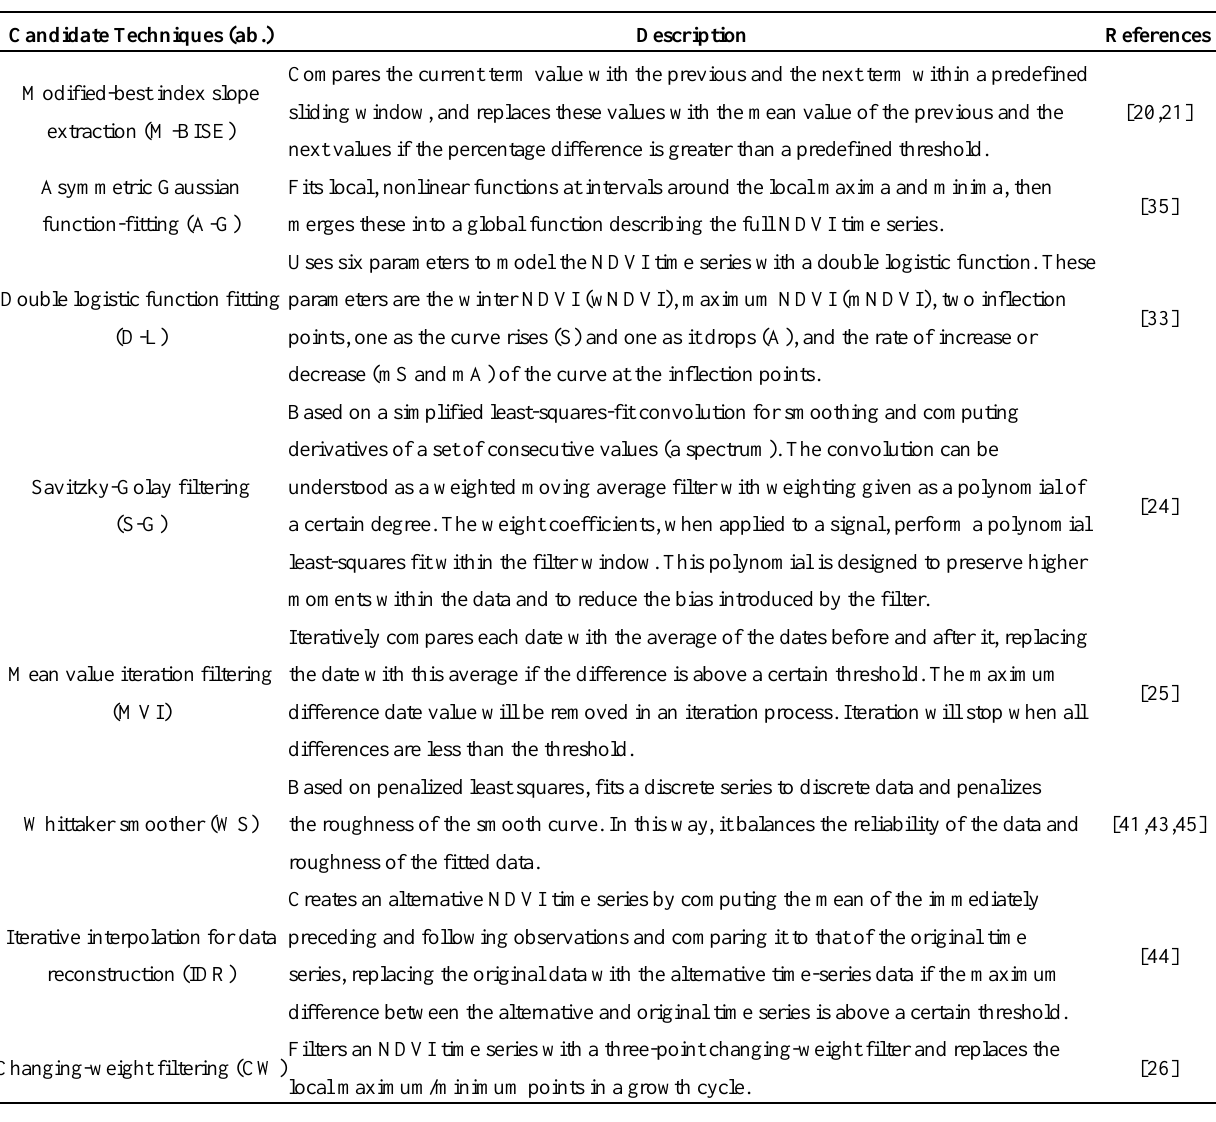
Table 2. Summary of the NDVI time-series reconstruction techniques selected for comparison. Candidate Techniques